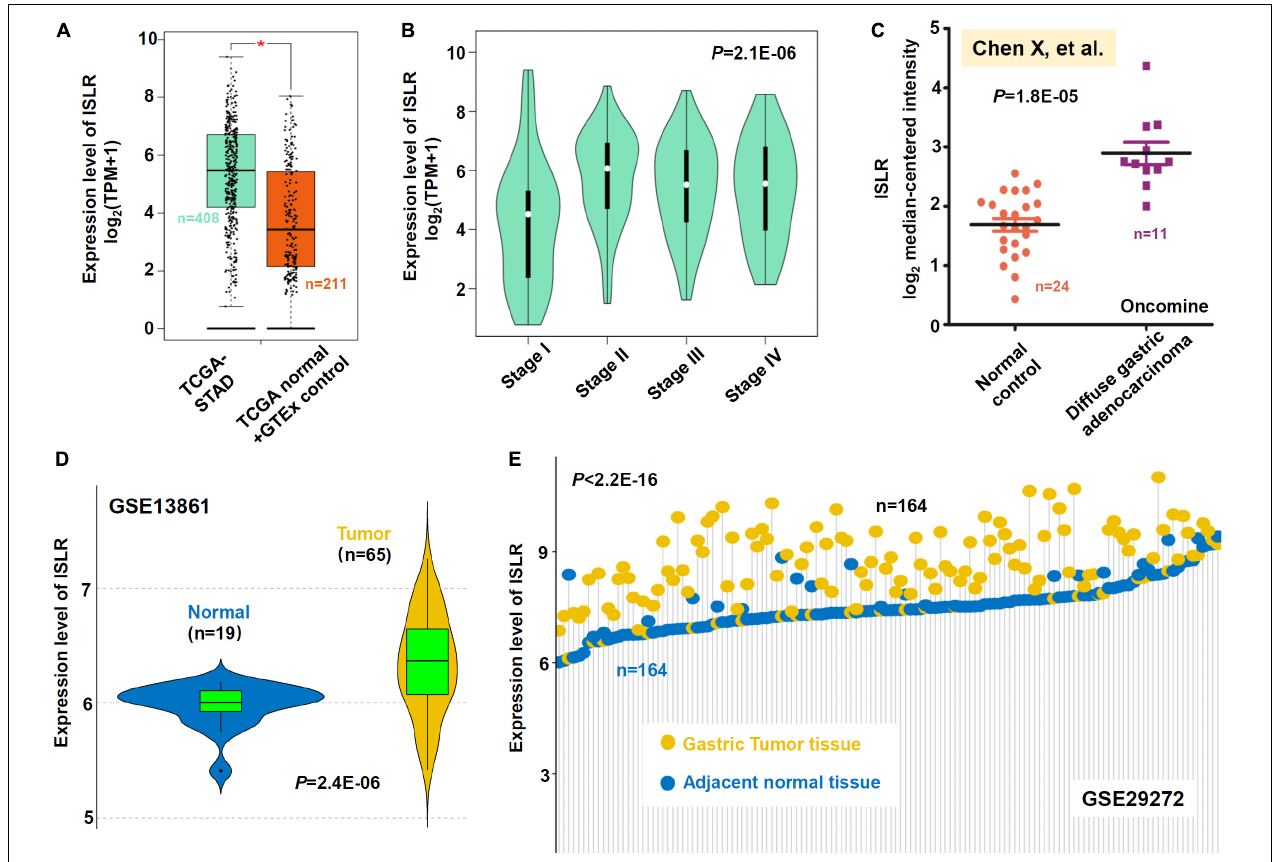
FIGURE 1 | Expression analysis of the ISLR gene between gastric cancer and negative control samples. (A) Expression level of ISLR between gastric cancer tissues in the TCGA-STAD cohort ( n = 408) and control tissues ( n = 211). Normal tissues in both the TCGA and GTEx databases were included as negative controls. * P < 0.05. (B) The expression level of ISLR among different pathologic stages (stage I, II, III, and IV) was also analyzed through GEPIA2. We also compared the expression level of ISLR between diffuse gastric adenocarcinoma cases and normal controls from the studies of “Chen et al. (2003)” through the Oncomine database (C) . The differences in ISLR gene expression between gastric cancer cases and normal controls in GSE13861 (D) and GSE29272 (E) were analyzed as well. Violin plots were used for GSE13861. Adjacent normal tissues were used for GSE29272, and the data were visualized by a dot